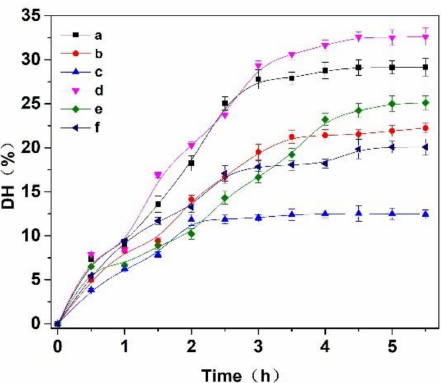
Figure 2. Effects of (a) papain, (b) trypsin, (c) flavourzyme, (d) papain:trypsin (1:1, w / w ), (e) pa- pain:flavourzyme (1:1, w / w ) and (f) trypsin:flavourzyme (1:1, w / w ) on the hydrolysis degree of the Cornus officinalis protein. Experimental conditions: the solid–liquid ratio of 1:20, reaction temperature 50 ◦ C, and initial pH value of